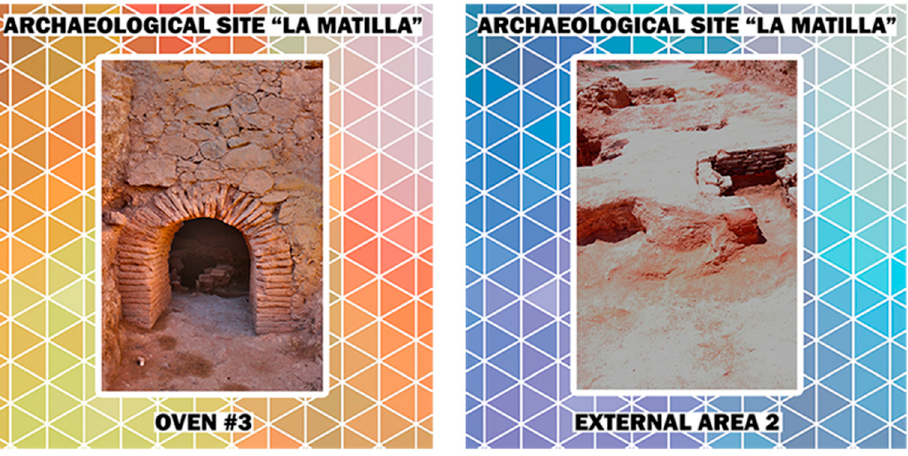
Figure 7. Two of the markers designed to be used in the AR application.